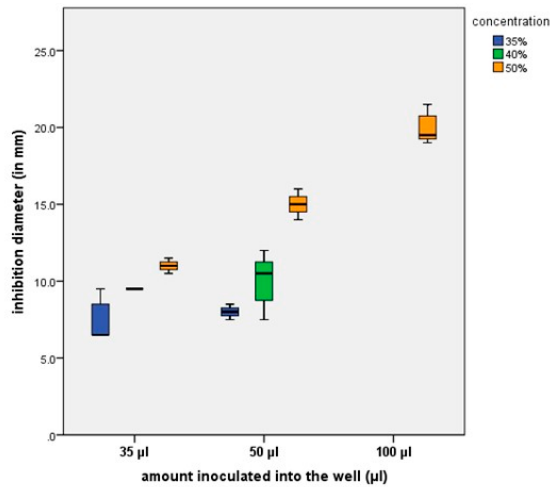
Figure 5. Mean values of inhibition diameters for S. mutans strain as a function of concentrations and quantities.